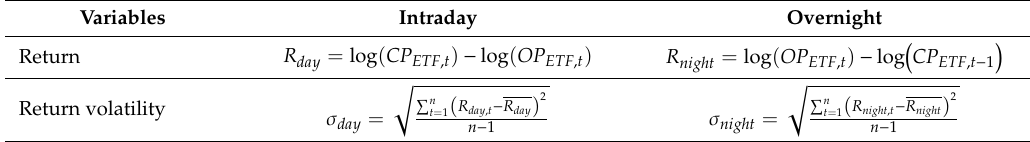
Table A4. Variables Measured for Intraday and Overnight